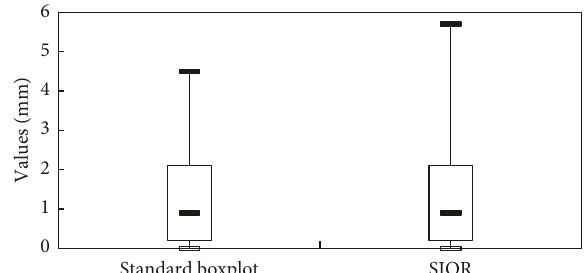
Figure 2: The fences of the two boxplot methods for Wuyigong